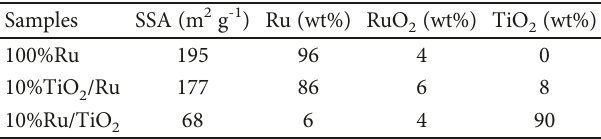
Figure 1: pXRD patterns of the RuTi series compared with the standards Ru 0 , RuO , and TiO . 2 2 Table 1: BET surface areas and weight percentages (as derived from pXRD) of the phases in the RuTi